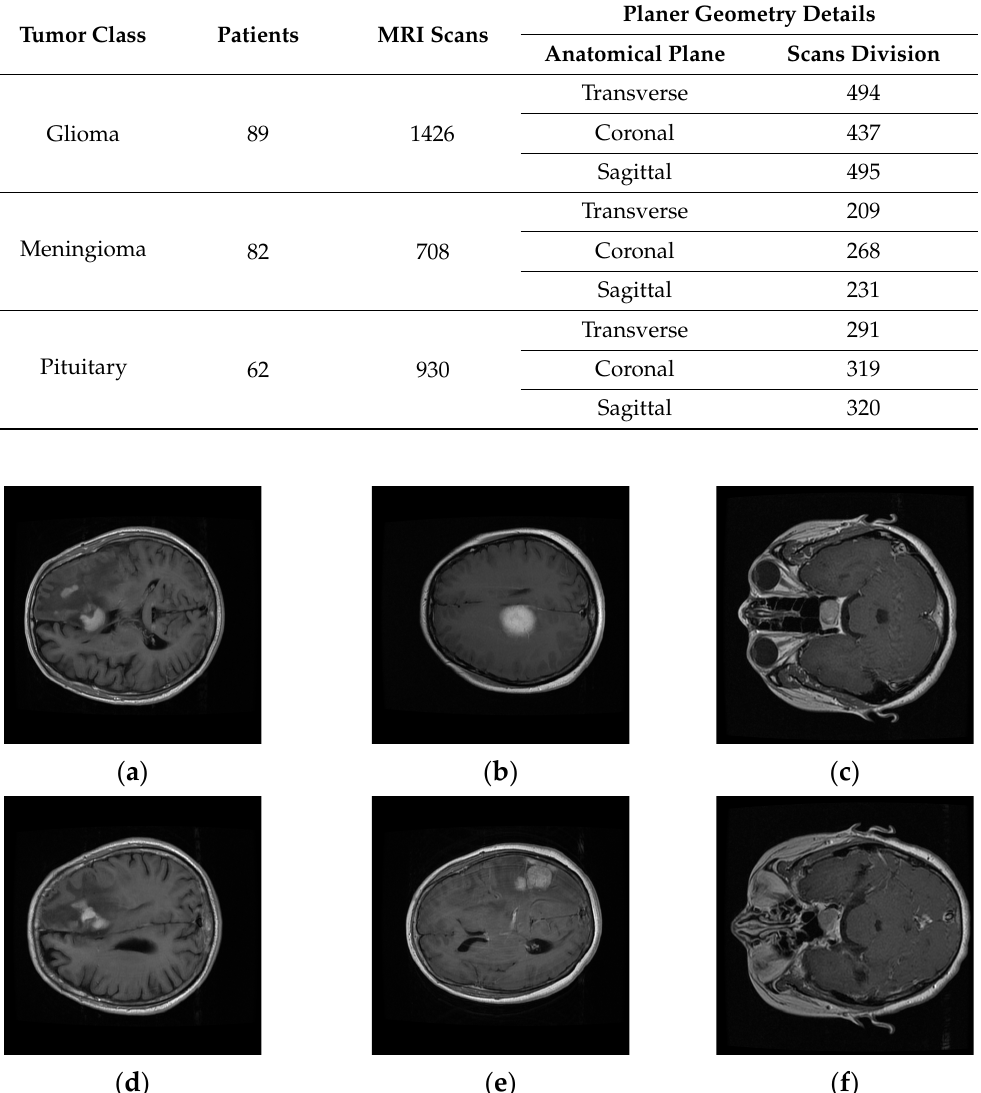
Figure 2. Intra-class variation existing in three different brain tumors for transverse view: ( a , d ) Glioma, ( b , e ) Meningioma, and ( c , f ) Pituitary tumors’ variation in CE-MRI dataset. Table 1. CE-MRI dataset with 3064 instances (233 patients), 512 × 512 pixels (pixel: 0.49 mm × 0.49 mm).